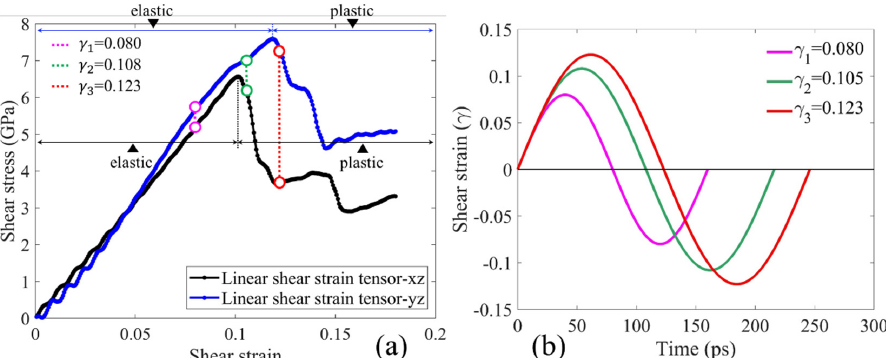
Figure 5. Mechanical properties and loading conditions of the atomic model. ( a ) Shear stress–strain curves under monotonic shear strain. Open symbols indicate the designed cyclic shear strain levels. ( b ) Shear strain–time curves for cyclic deformation with different periods and strain amplitudes. Periods are 160 ps ( γ 1 ), 216 ps ( γ 2 ) and 246 ps ( γ 3